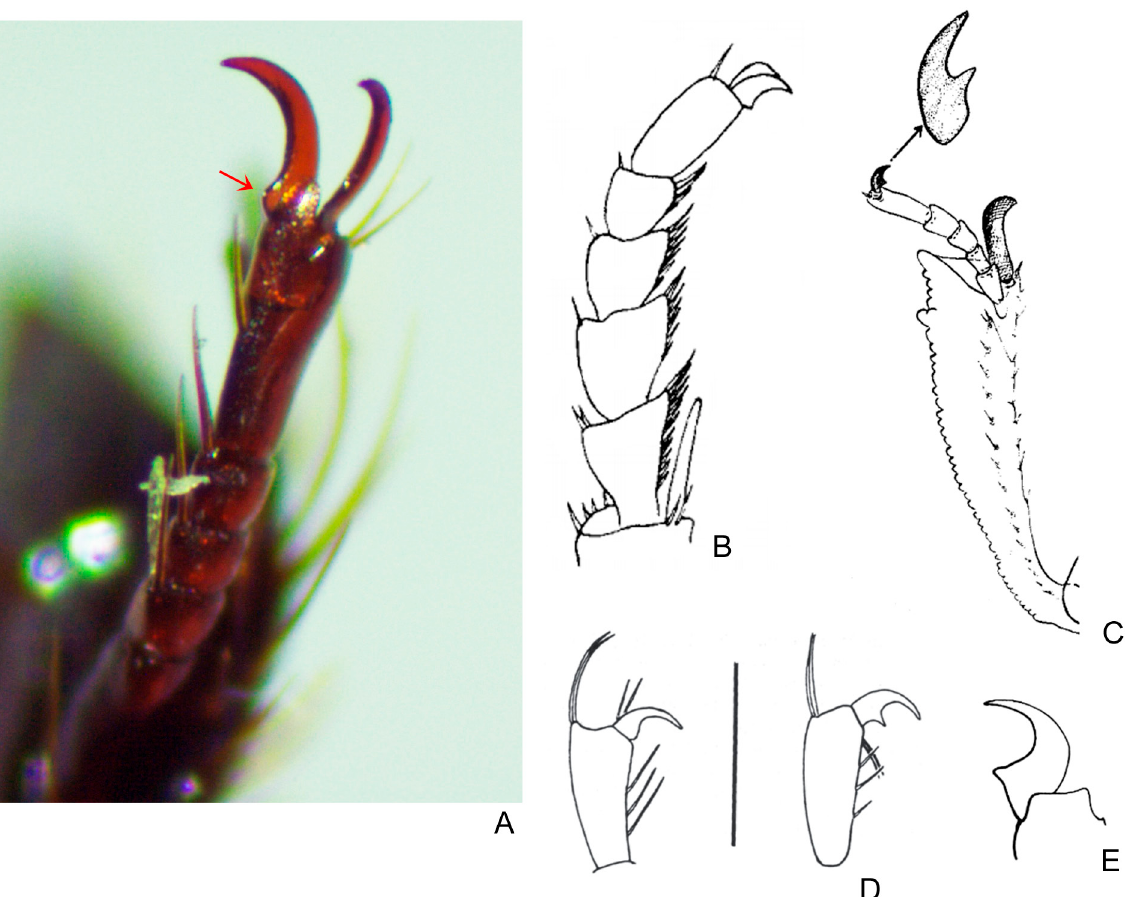
Fig. 5. Subdentate tarsal claws in different groups of dung beetles. The presence of this form of tarsal claw was seen as evidence for a close phylogenetic relationship between several groups of Scarabaeinae distributed over the continents of former Gondwana. A . Protarsal claws of Sylvicanthon proseni (Martínez, 1949) stat. et comb. nov. Red arrow indicates the basal agularity of the claw. B . Pseudocanthon vitraci (Fleutiaux & Sallé, 1889) (modified from Matthews 1966). C . Canthonella parva (Chapin, 1930) (modified from Halffter & Martínez 1967). D . Lepanus penelopae Matthews & Weir, 2002 (left) and L. loftyensis Matthews & Weir, 2002 (right) (modified from Matthews & Weir 2002). E . Oficanthon mirabilis Paulian, 1985 (modified from Paulian